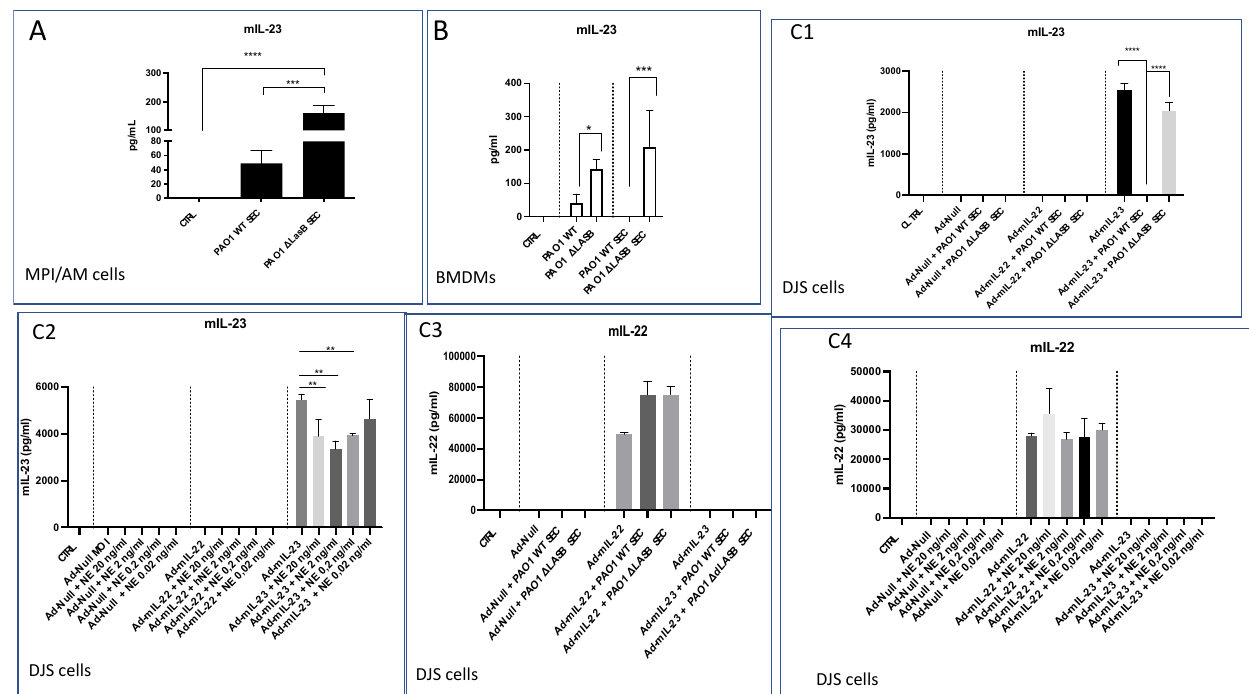
Figure 7. PAO1 LasB and neutrophil elastase down-regulate IL-23, but not IL-22 protein accumulation. ( A ) 0.5.10 6 MPI cells (in P24 wells) were either mock (serum-free RPMI)-treated or incubated with either WT-PAO1- or ∆LasB-PAO1 secretomes (SEC, 5%) during 6 h. Cell media were collected, centrifuged, and supernatants were assessed by ELISA for IL-23 content. ( B ) Bone-marrow-derived macrophages (BMDMs, seeded at 2.10 6 cells/P24 plate) were either treated in serum-free RPMI with WT-PAO1- or ∆LasB-PAO1 secretomes (SEC, 1%) or infected with either WT- or ∆LasB-PAO1 (moi 1); 4 h later, cell media were collected, centrifuged, and supernatants were assessed by ELISA for IL-23 content. ( C ) 0.5.10 6 cells DJS Clara cells (in P24 wells) were infected in serum-free with either Ad-null, Ad-23, or Ad-IL-22 (moi 50); 16 h later, cells were either mock-treated, or treated with WT-PAO1-SEC, ∆LasB-PAO1 SEC (5%, ( C1 – C3 )), or increasing concentrations of purified neutrophil elastase (NE, ( C2 – C4 )). After a further 24 h, cell media were collected, centrifuged, and supernatants were assessed by ELISA for IL-23 and IL-22 content. Statistical significance was assessed with ANOVA test, followed by Tukey post hoc multivariate analysis. * = p < 0.05. ** = p < 0.01 ; *** = p <